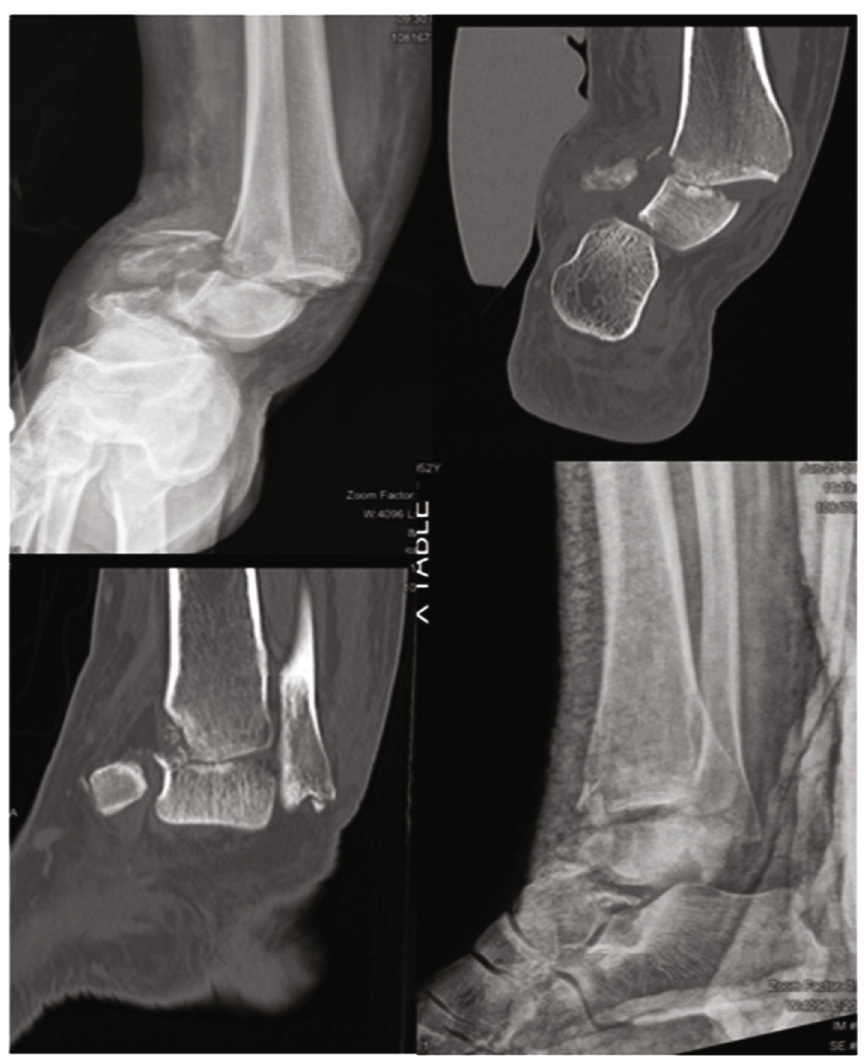
Figure 1: Injury fi lms and CT scan demonstrated 180 ° inversion of proximal talus such that the dome was adjacent to the subtalar joint. The talus remained inverted after initial closed reduction attempt in the emergency